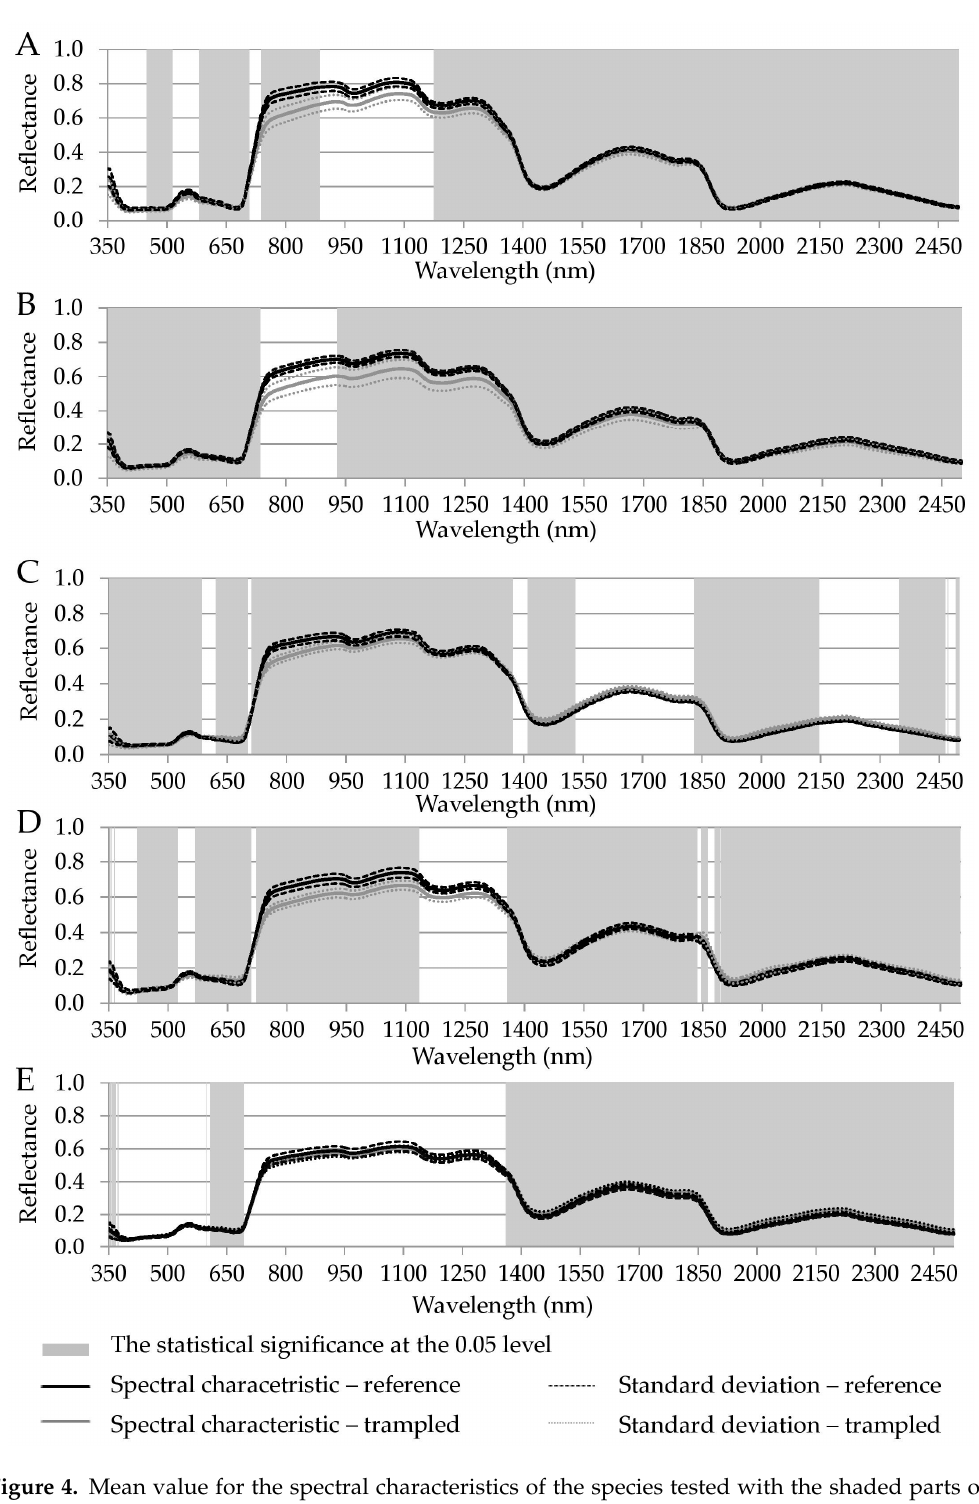
Figure 4. Mean value for the spectral characteristics of the species tested with the shaded parts of the electromagnetic spectrum indicating where a significant statistical relationship at the 0.05 level was found: ( A ) Luzula alpino-pilosa (reference n-840, trampled n-770); ( B ) Festuca picta (reference n-280, trampled n-250); ( C ) Juncus trufidus (reference n-690, trampled n-610); ( D ) Agrostis rupestris (reference n-1030, trampled n-940); and ( E ) Oreochloa disticha (reference n-340, trampled n-290).